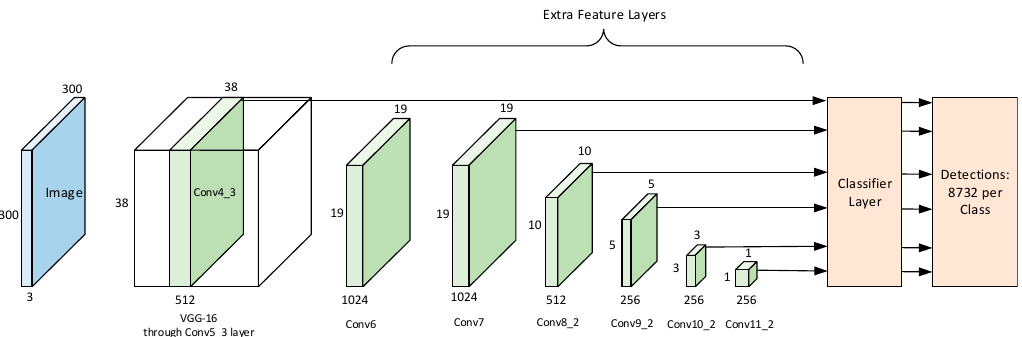
Figure 4. Single-shot multibox detector (SSD) network structure.